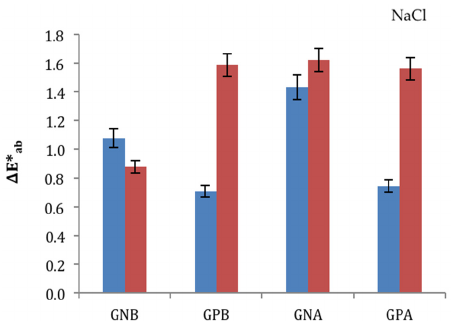
Figure 8. Total colour changes ( Δ E * ab ) in the accelerated ageing induced by NaCl and Na 2 SO 4 salt cycles. Blue bars represent the differences after seven cycles. Orange bars represent the differences after 14 cycles. The sample codes are shown in Table 1.